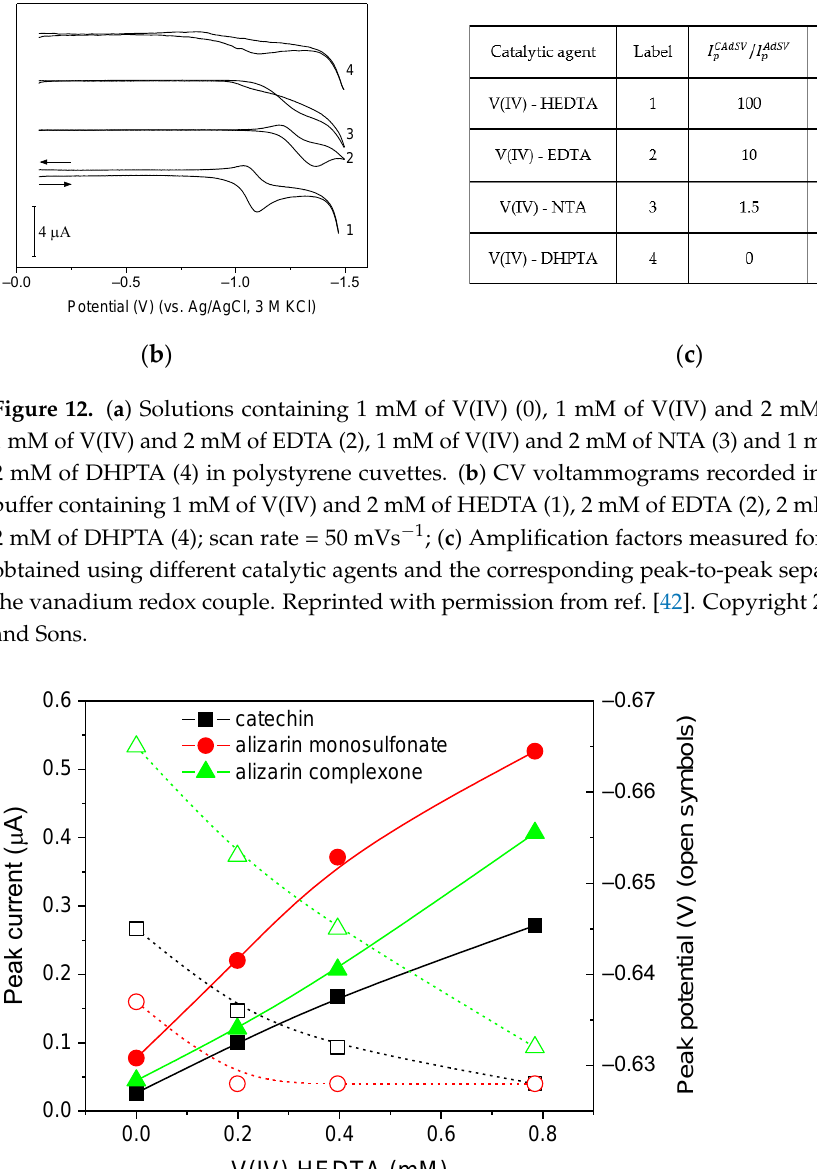
Figure 13. The influence of V(IV)-HEDTA concentration on DP peak current and peak potential of Ge(IV) for solutions containing 5 µM of catechin, 5 µM of alizarin sodium monosulfonate or 5 µM of alizarin complexone. Examined solution: 50 µM Ge(IV), 0.1 M acetate buffer (pH = 4.24). The HMDE electrode served as the working electrode.